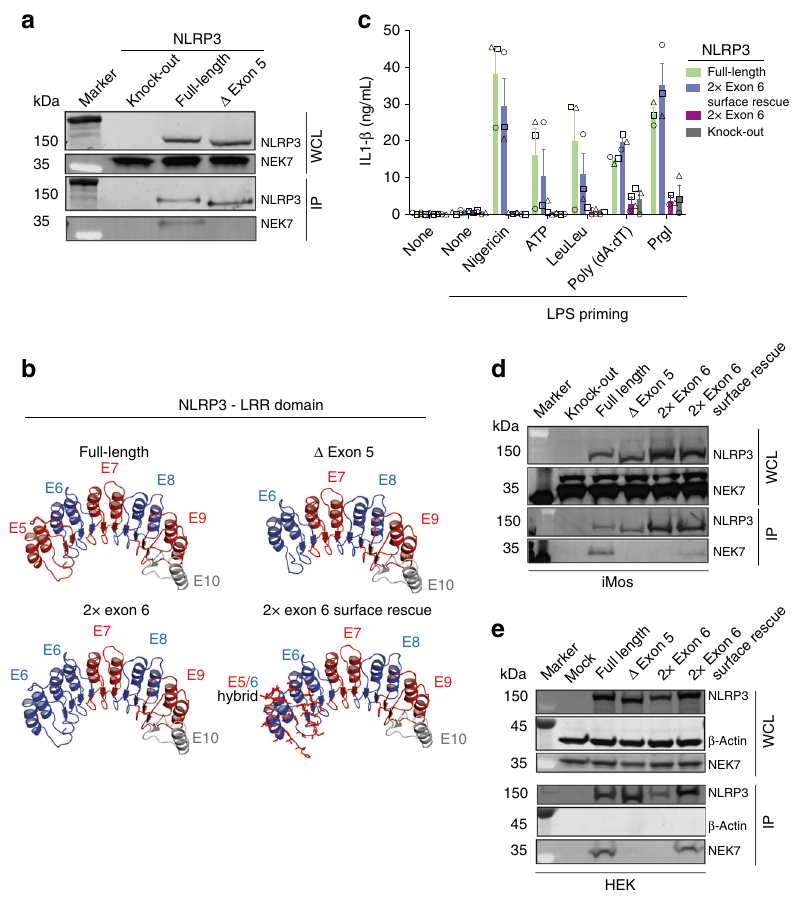
Fig. 6 NLRP3 Δ exon 5 lacks NEK7 interaction surface. a Co-immunprecipitation (IP) from iMos stably expressing the respective NLRP3-mCitrine variants. IP was performed in GFP-trap plates. b Models of the NLRP3 LRRs based on the crystal structure of human ribonuclease inhibitor. Shown are the LRR model structures of NLRP3 full-length and NLRP3 Δ exon 5, as well as two arti fi cially created hybrid LRRs: NLRP3 LRR lacking exon 5 but carrying a duplicate exon 6, and NLRP3 LRR carrying a duplicate exon 6 in which all surface amino acids of exon 5 were rescued. c NLRP3-de fi cient iMos were reconstituted with full- length or the hybrid NLRP3-mCitrine variants from b . IL-1 β measured after priming with LPS and activation of the NLRP3, AIM2 or NLRC4 in fl ammasomes. Mean and SEM of three experiments. Each individual data point from one experiment is plotted using a unique overlaid symbol shape d Co-IP from iMos stably expressing the respective NLRP3-mCitrine variants. IP was performed in GFP-trap plates. Representative of two independent experiments. e Co-IP from HEK cells transiently transfected to express the respective NLRP3-mCitrine variants. IP was performed in GFP-trap plates. Representative of three independent experiments. See also Supplementary Fig. 6 and Supplementary Table 2. Source data are provided as a Source Data fi